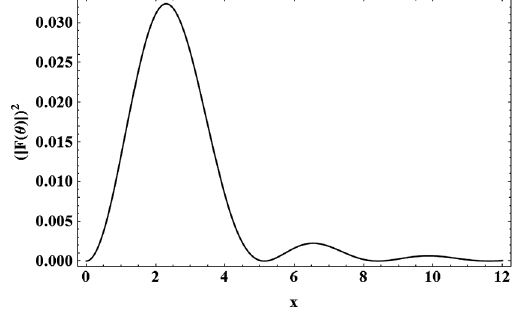
FIG. 5. The radiation pattern in power (at ct > R þ a